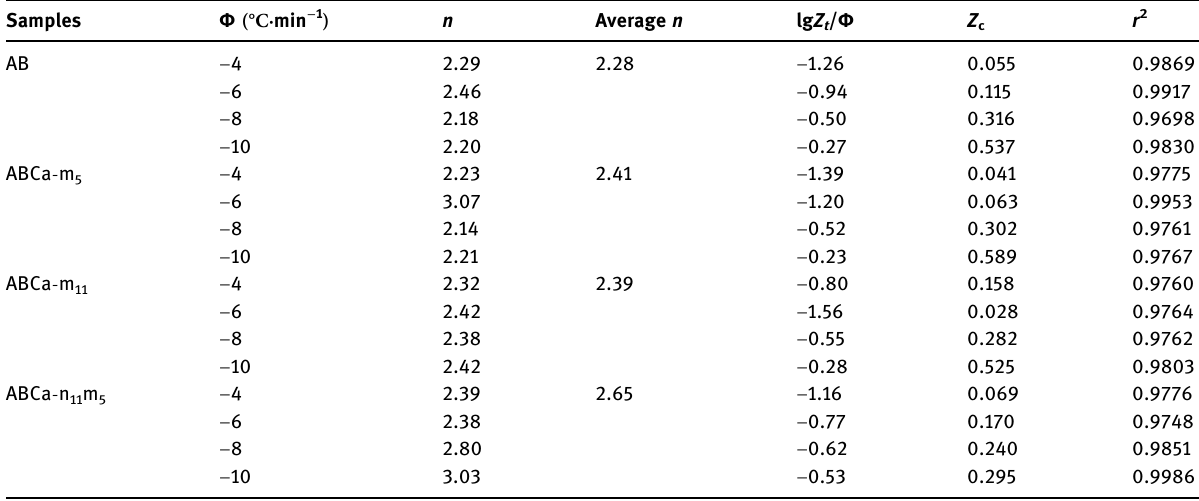
Table 7: Parameters of non - isothermal crystallization for AB, ABCa - m 5 , ABCa - m 11 , and ABCa - n 11 m 5